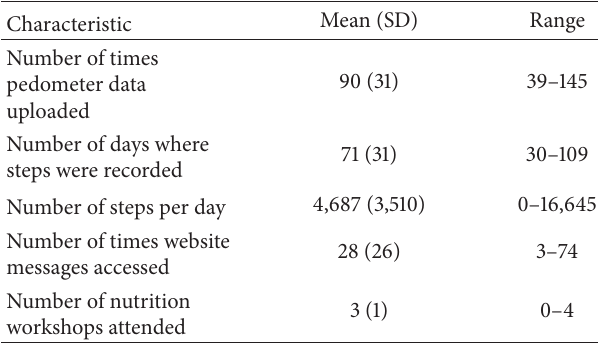
Table 3: Pedometer and nutrition workshop